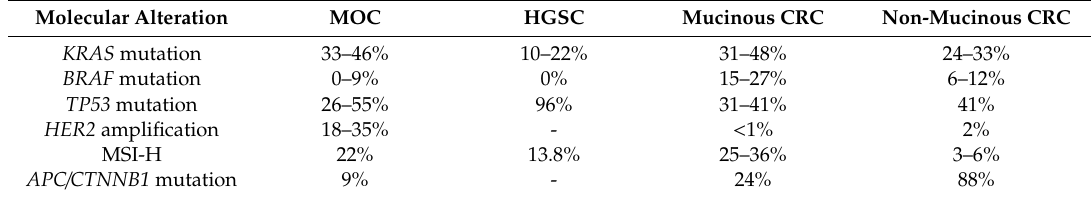
Table 2. Frequency of molecular alterations in MOC, HGSC, mucinous, and non-mucinous CRC. Molecular Alteration